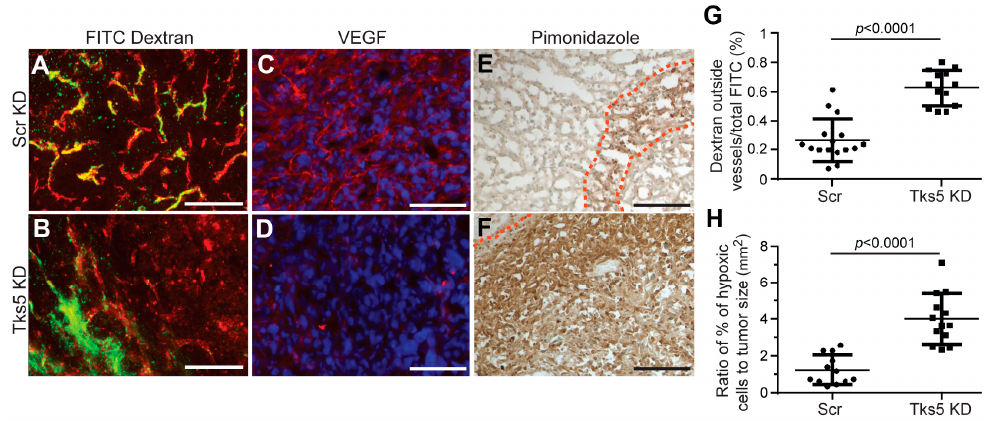
Figure 3. Reduced Tks5 expression in mammary tumor cells results alters tumor blood vessels. Blood vessels in mammary tumors formed by MDA-MB-231 cells transfected with scrambled shRNA (Scr KD) and Tks5 shRNA (Tks5 KD) were analyzed for leakage of FITC-dextran, localization of VEGF-A, and levels of tumor hypoxia. ( A ) and ( B ): Levels of FITC-dextran (green) outside of CD31-positive vessels (red) were determined by confocal microscopy. Increased leakage from vessels in Tks5 knockdown tumors is quantified in ( G ). ( C ) and ( D ): Confocal microscopy of immunolabeling sections was used to localize VEGF-A (red) to tumor vessels in control tumors. This vascular localization is largely lost in Tks5 knockdown tumors. Blue = DAPI. ( E ) and ( F ): Pimonidazole was injected intravenously into tumor-bearing mice and allowed to circulate for 10 min. Immunolabeling was then used to localize and quantify pimonidazole accumulation in areas of hypoxia. Dashed lines delineate the borders of hypoxic areas. Hypoxia is greatly increased in Tks5 knockdown tumors ( H ). Scale bars: 100 μ m. Data taken from (Blouw et al., [29]).